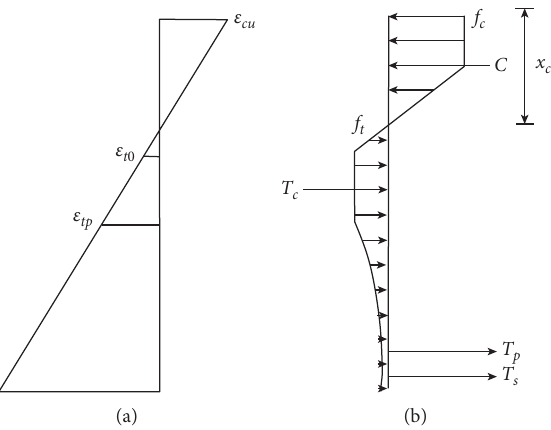
Figure 8: Stress-strain under the pure bending moment: (a) strain distribution; (b) stress distribution.